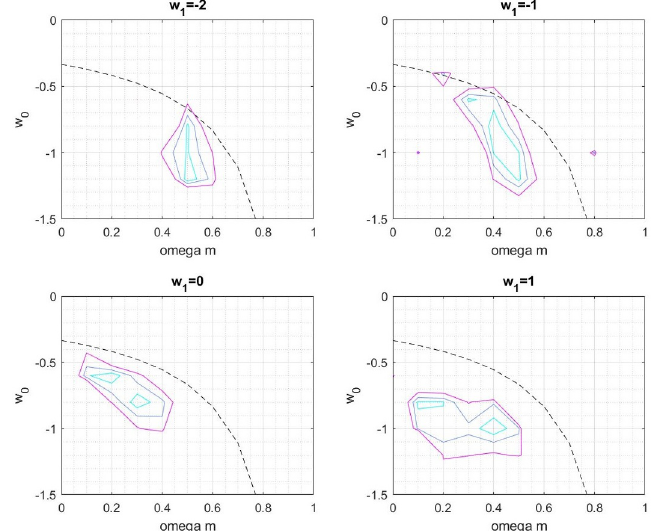
Figure 5: Plots of w 0 against Ω m for values of − 2 < w 1 < 1, with 1 σ , 2 σ and 3 σ contours. The best fit values are Ω m = 0 . 4, w 0 = − 0 . 8, w 1 = − 1, with a χ 2 value of − 229 . 4125.